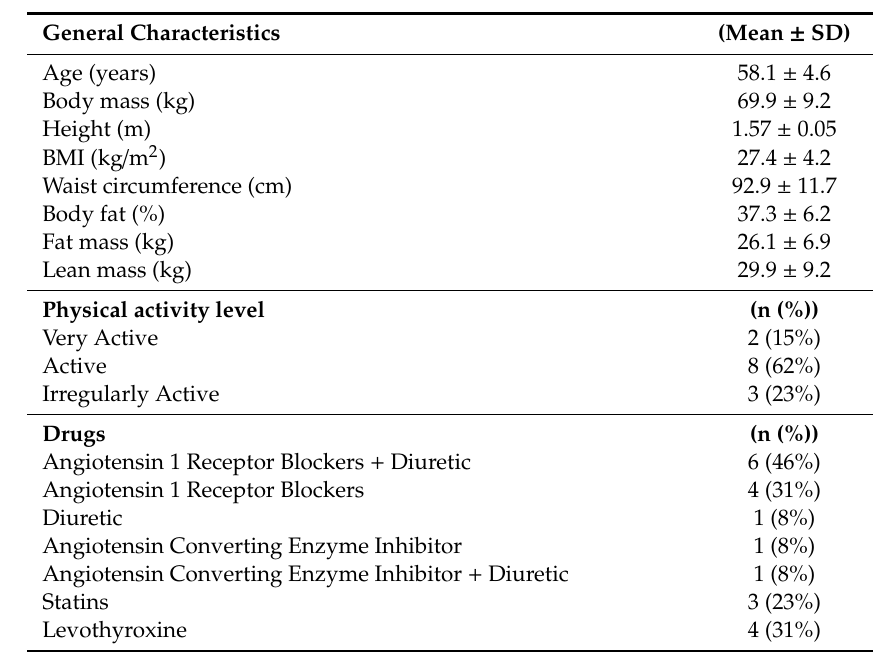
Table 1. General characteristics of the participants. BMI: Body mass index. The general characteristics values are shown as mean ± standard deviation (SD), physical activity level and drugs are shown as: number of subjects (n) and percentage of the total number of subjects